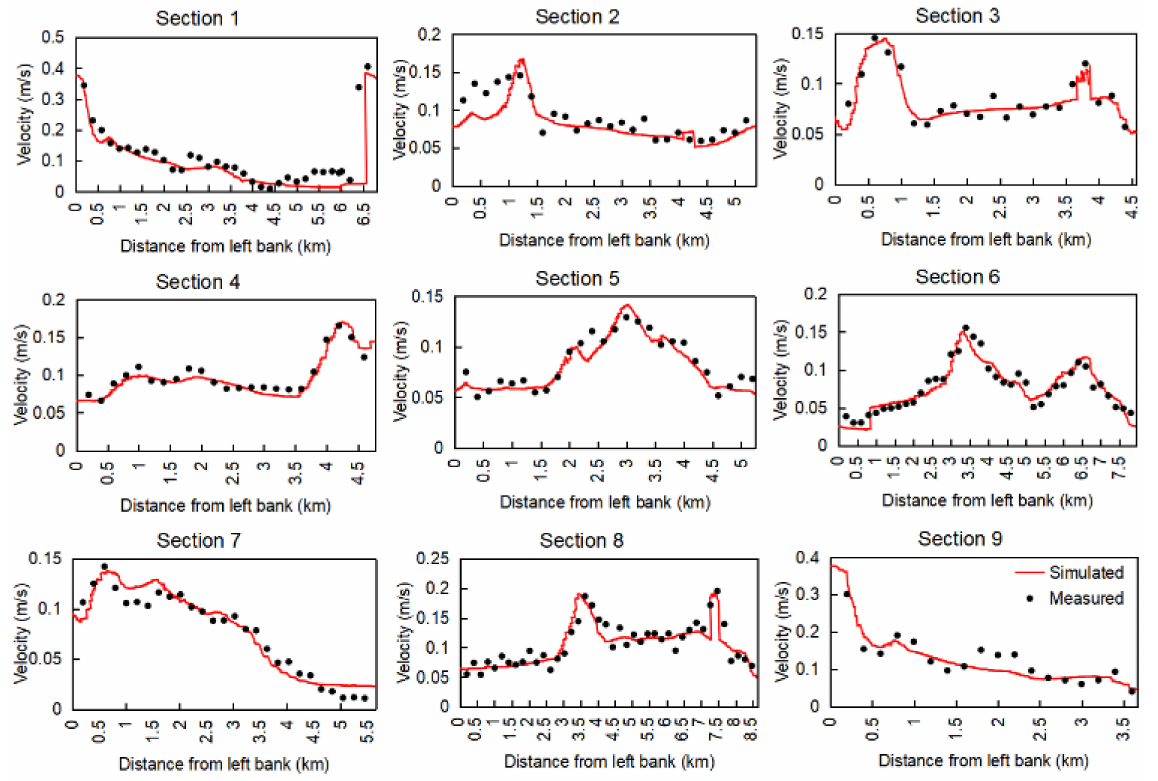
Figure 5. Validation of the simulated velocity along nine